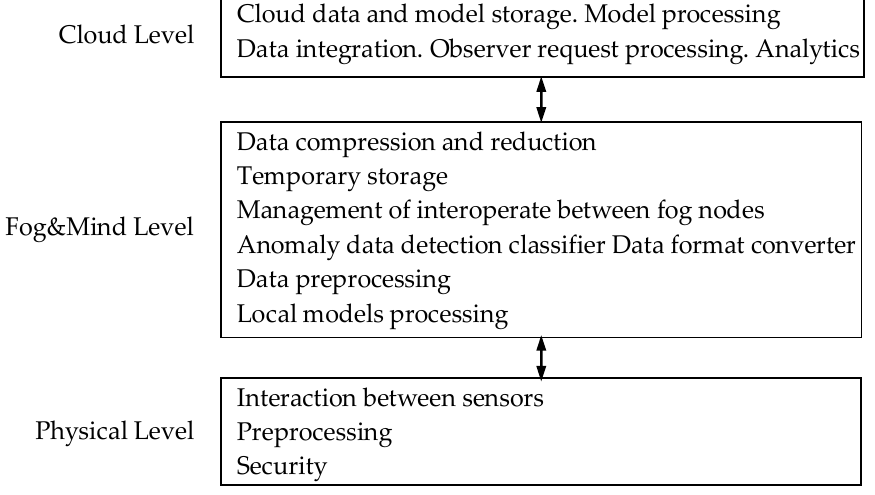
Figure 5. Data collection (DC) method used at the physical and network levels.